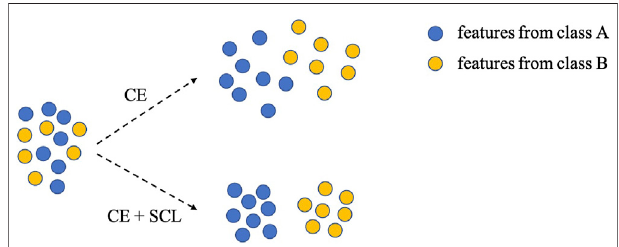
FIGURE 2 | Conceptualization of cross-entropy loss L CE ( eq. (2) ) and FSCC loss L ( eq. (1) ). There are two kinds of extracted features of classes A and B. When adopting cross-entropy loss L CE to train the model, the inter- class distance is close. Instead, when adopting the loss of FSCC L , the inter-class distance increases, while intra-class distance